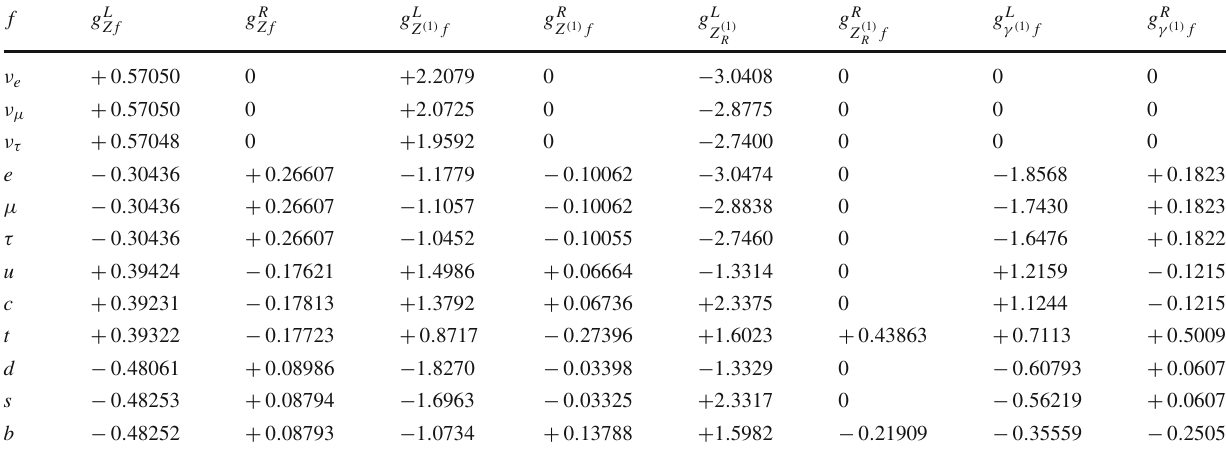
Table 7 Z (cid:3) couplings of fermions for θ H = 0 . 09, c l , c q < 0 The same unit as in Table 3